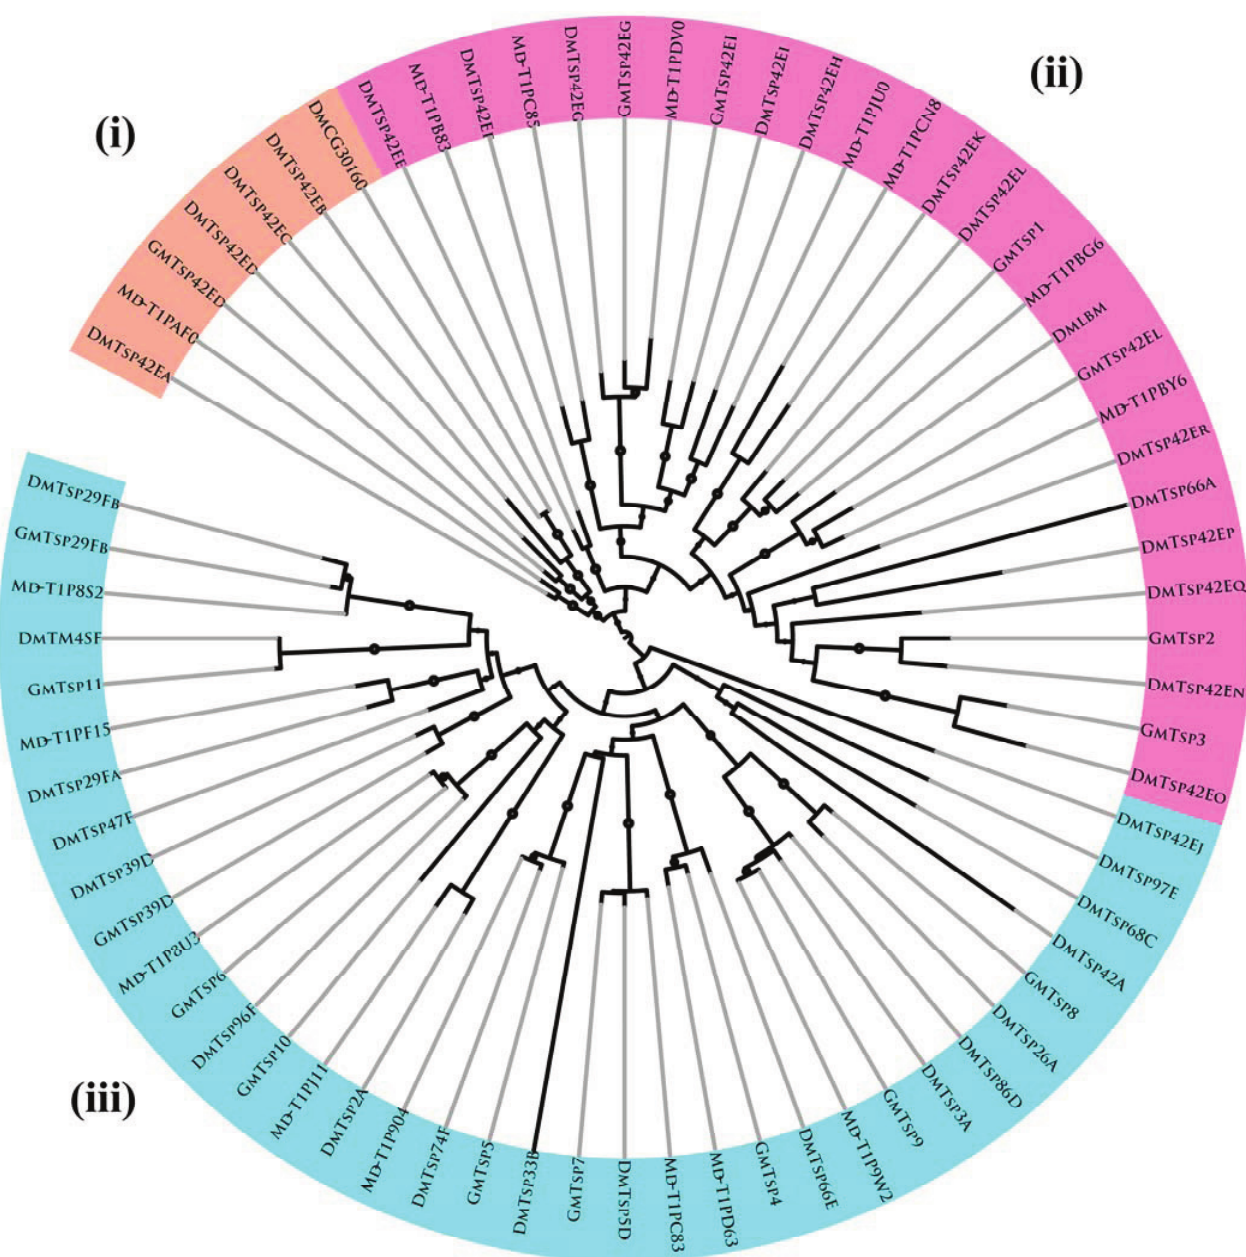
Figure 3. Phylogenetic analysis of tetraspanin homologs based on amino acid sequences: The phylogenetic tree shows clustering of the Tsps into three main clades and nine sub-clades, which display 1:1:1 orthologous relationships of these proteins. The phylogenetic tree was constructed using the ML method implemented in PhyML [81] using the LG model of amino acid substitution [54]. The seventeen putative tsetse fly ( G. morsitans ) tetraspanins